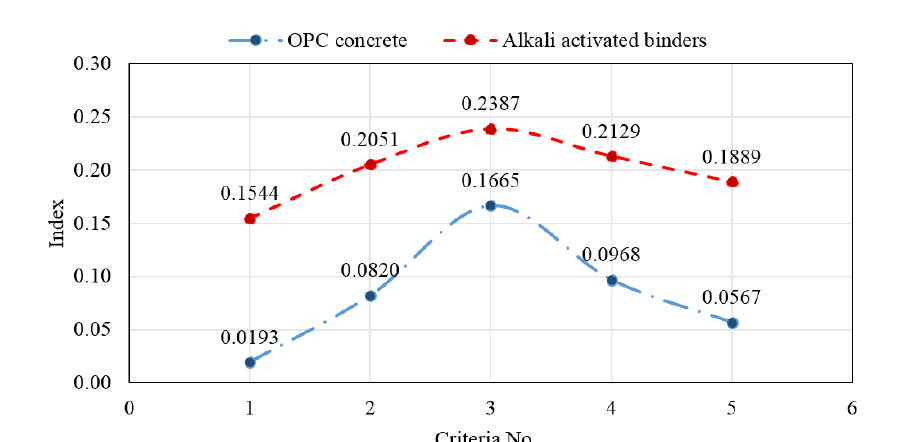
Figure 9. Selection index based on the criteria.